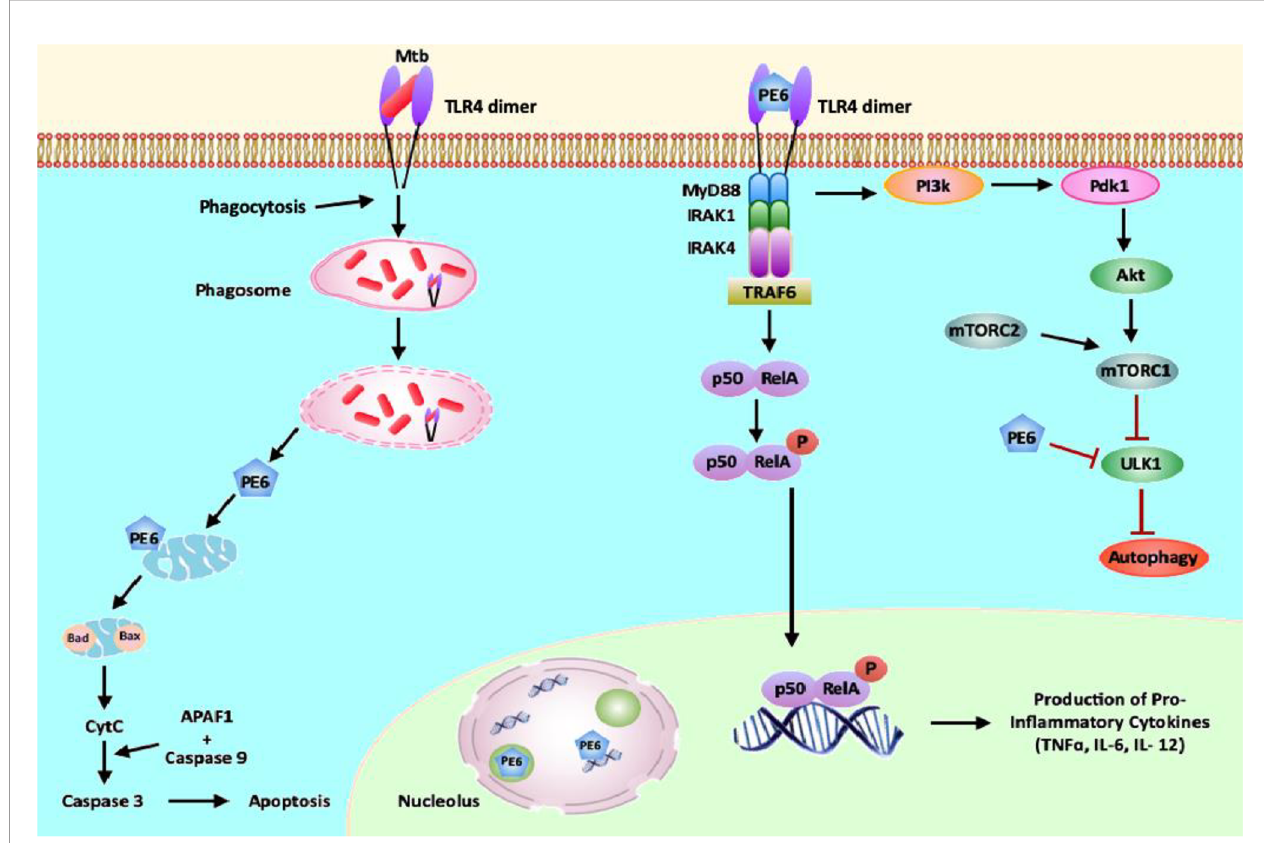
FIGURE 10 | PE6 interacts with surface immune receptor TLR4 and affects downstream signaling cascade. PE6 is a speci fi c TLR4 agonist that recruits adaptor protein Myd88 to affect downstream signaling. Engagement of PE6 to TLR4 activates canonical NF ĸ B signaling pathways involving NF ĸ B1 (P50) and RelA (P65). Activation of canonical NF ĸ B signaling induces increased production of proin fl ammatory cytokines TNF- a , IL-6, and IL12. PE6 differentially targeted into nucleus/ nucleolus and mitochondria, controls the expression of Nucleolin, indicating possible exploitation of Nucleolin functions to modulate host-directed defenses generated against M. tb . PE6 induces increased apoptosis through the production of pro-apoptotic molecules Bax, Cytochrome C, and pcMYC. PE6 inhibits autophagy initiation via repression of autophagy initiating kinase ULK1 and activation of autophagy master regulator MtorC1 mediated by TLR4. Like other virulence effectors of M. tb , PE6 displays moonlighting function to dampen and subdue innate host defenses targeted against the pathogen for successful